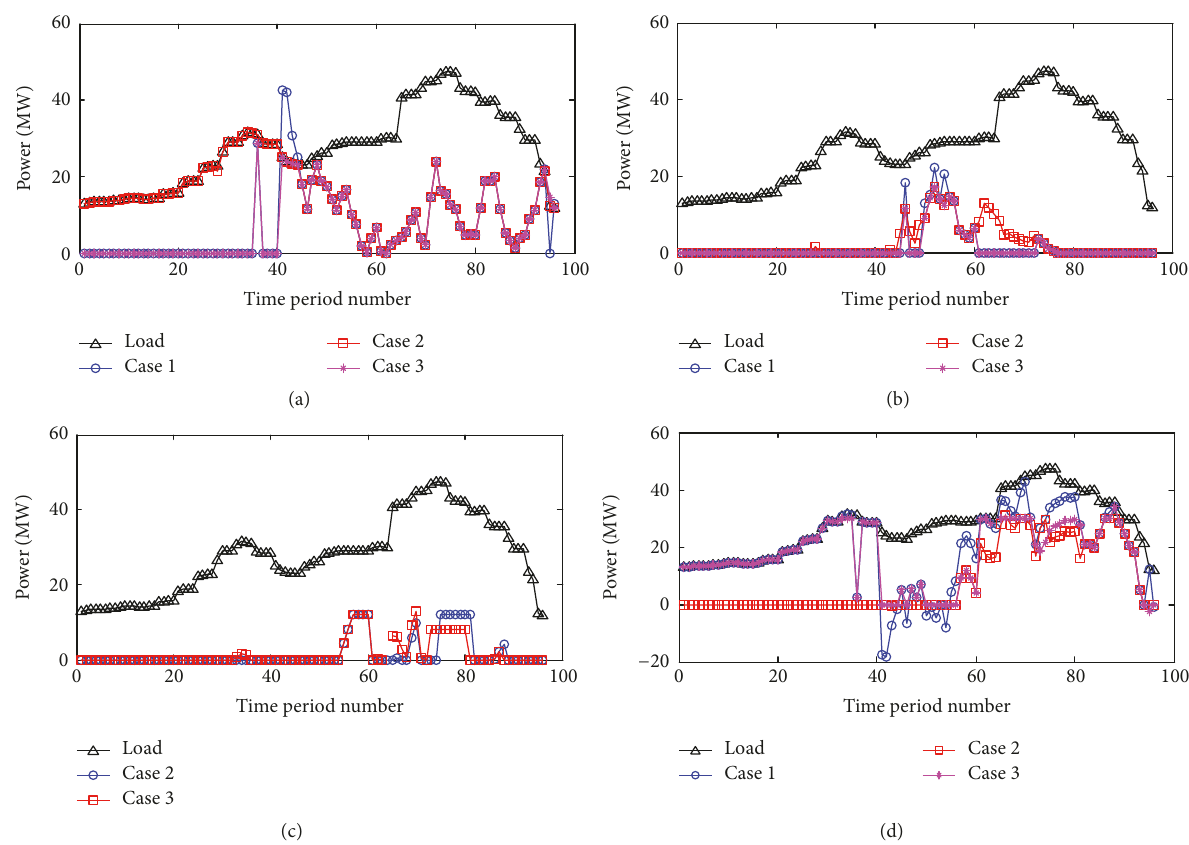
Figure 8: Power dispatching comparison, respectively, for (a) wind generation, (b) photovoltaic generation, (c) battery discharging, and (d) exchanged power from primary